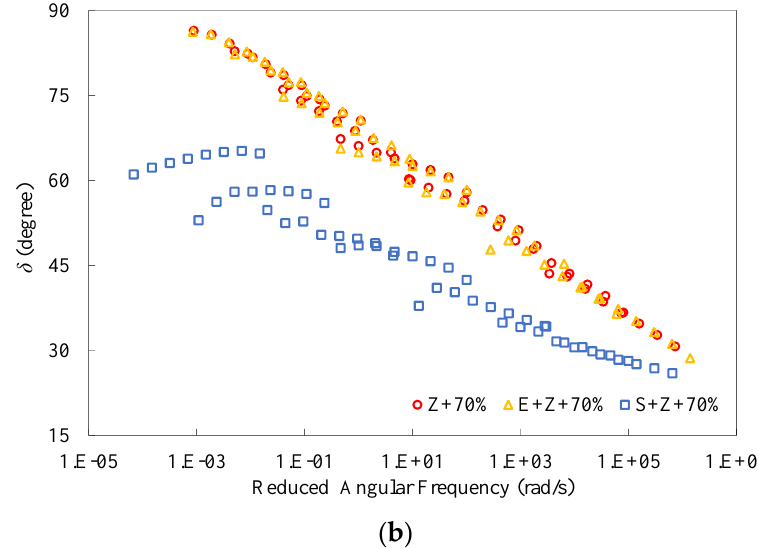
Figure 19. Master curves of dynamic modulus and phase angle of the warm-mix recycled binders at the RAP binder content of 70%.